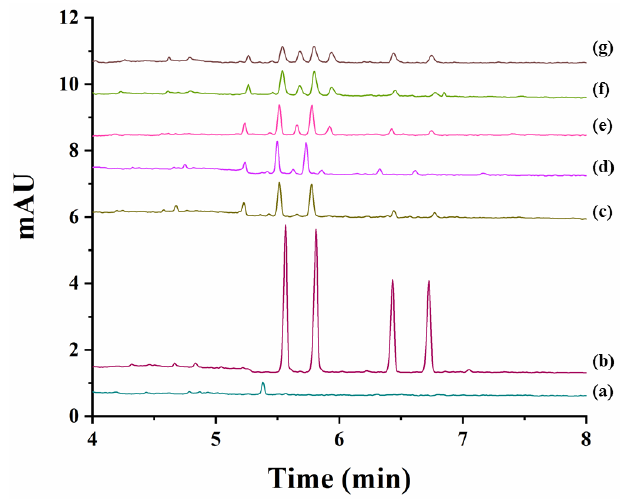
Figure 5. Electropherograms corresponding to the analysis of the extracts obtained from soil samples spiked with 40 mg L −1 carfentrazone-ethyl racemate (degradation study of carfentrazone-ethyl in soil samples). ( a ) Soil extract blank; ( b ) Standard solution of carfentrazone-ethyl racemate and carfentrazone racemate at 40 mg L −1 and 20 mg L −1 , respectively; ( c ) soil extract after zero days; ( d ) soil extract after one day; ( e ) soil extract after three days; ( f ) soil extract after four days; ( g ) soil extract after seven days.